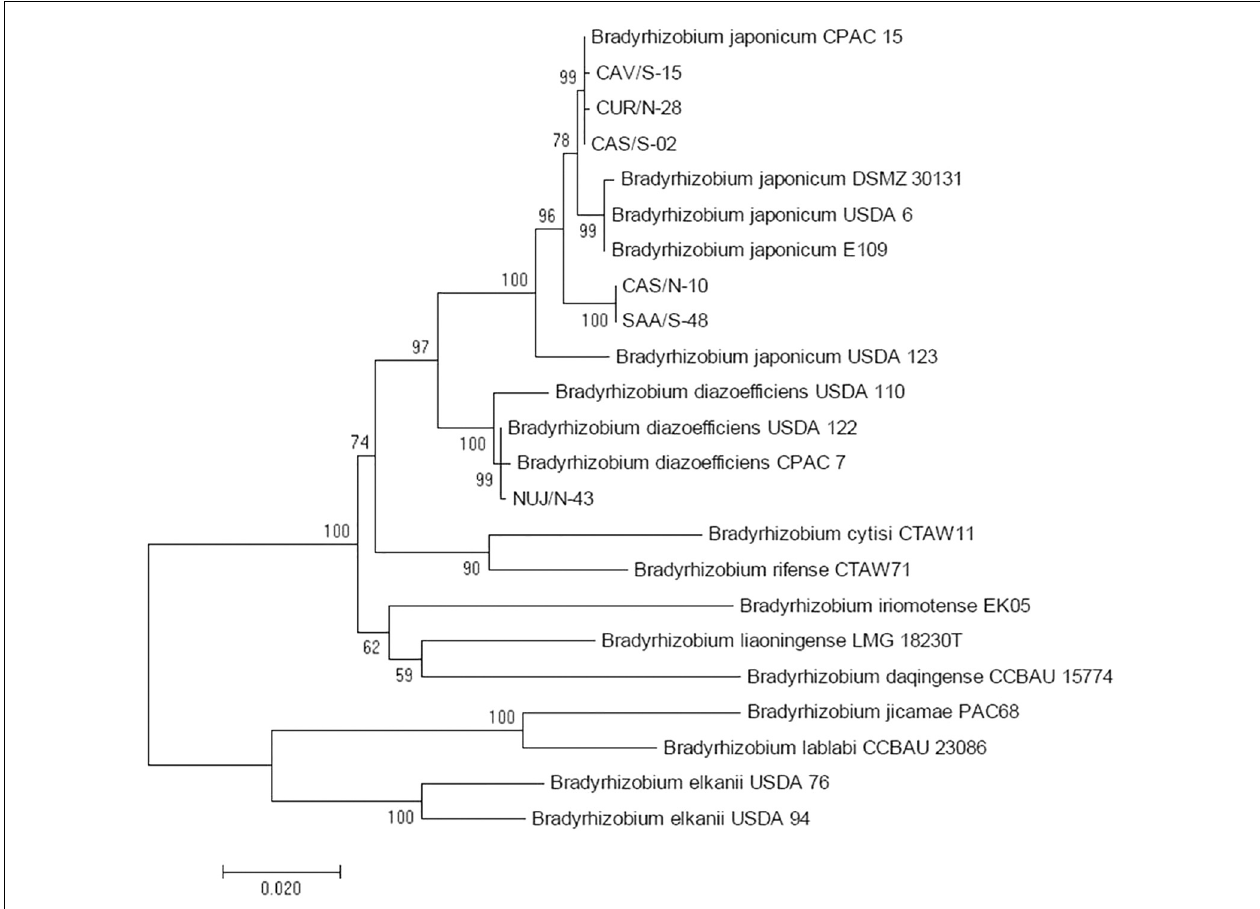
FIGURE 3 | Maximum likelihood cladogram for the concatenated atpD , glnII , and recA fragment sequences to distinguish B. diazoefficiens from B. japonicum among picked SNAP-isolates in comparison with reference strains. Next to the nodes the percentage of replicate trees in which the associated taxa clustered together in the bootstrap test with 1,000 replicates are shown. Branch lengths in the tree are scaled in the same units as those of the evolutionary distances (scale bar) used to infer the phylogenetic tree.